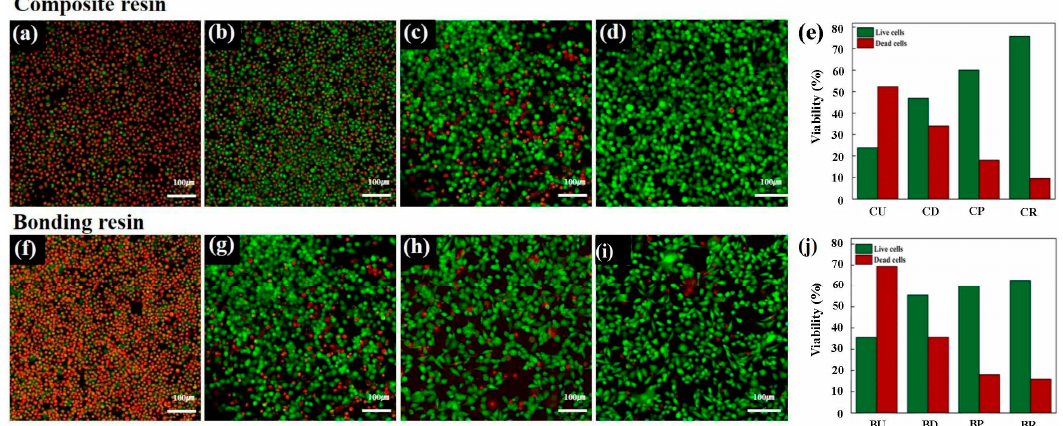
Figure 5. Confocal laser microscopy images following calcein AM and ethidium homodimer-1 staining of L929 cells. Cells were exposed to extracts from ( a ) uncured composite resin; ( b ) directly cured composite resin; ( c ) post-cured composite resin; ( d ) composite resin after removing the unreacted layer; ( e ) Live/Dead Assay® quantified the live and dead cells in equivalent surface areas of composite resin; ( f ) uncured bonding resin; ( g ) directly cured bonding resin; ( h ) post-cured bonding resin; ( i ) bonding resin after removing the unreacted layer; ( j ) Live/Dead Assay ® quantified the live and dead cells in equivalent surface areas of bonding resin. Live cells are stained green and dead cells are stained red for confocal laser microscope images.